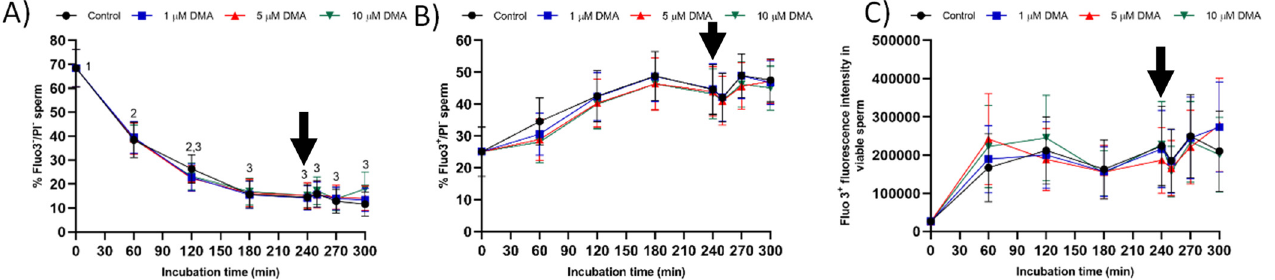
Figure 9. Percentages of viable sperm with low ( A ) and high intracellular calcium levels ( B ), and fluorescence intensity of Fluo3 + in viable sperm ( C ) during in vitro capacitation in the control and samples blocked with 1, 5, and 10 µM DMA. Different numeral superscripts indicate significant differences between two consecutive time points within a treatment ( p < 0.05); since the pattern of variation of the percentage of viable sperm with low intracellular calcium levels was similar between control and blocked samples throughout the incubation time, all treatments have the same numeral superscript assigned to each time point. Lack of numeral superscripts indicate no significant differences in the percentage of viable sperm with high intracellular calcium levels and in Fluo3 + fluorescence intensity between treatments within a single time point ( p > 0.05). The arrow indicates the addition of 10 µg/mL of progesterone at 240 min of incubation. Results are expressed as the mean ± SEM ( n = 9).